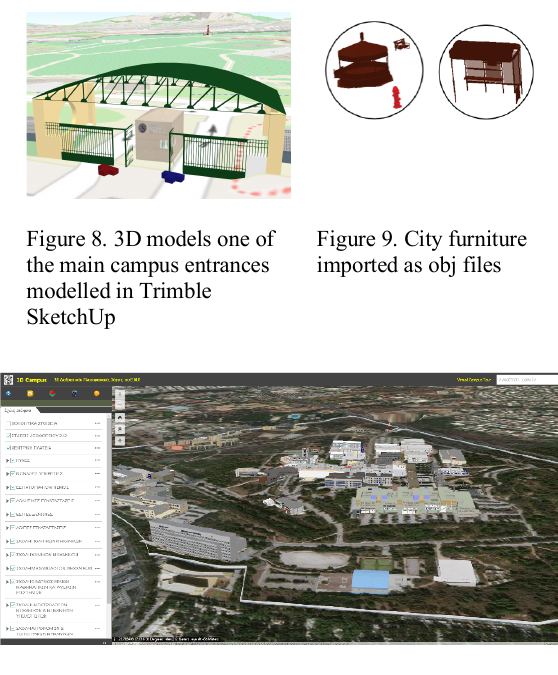
Figure 10: Interactive 3D WebGIS viewer of